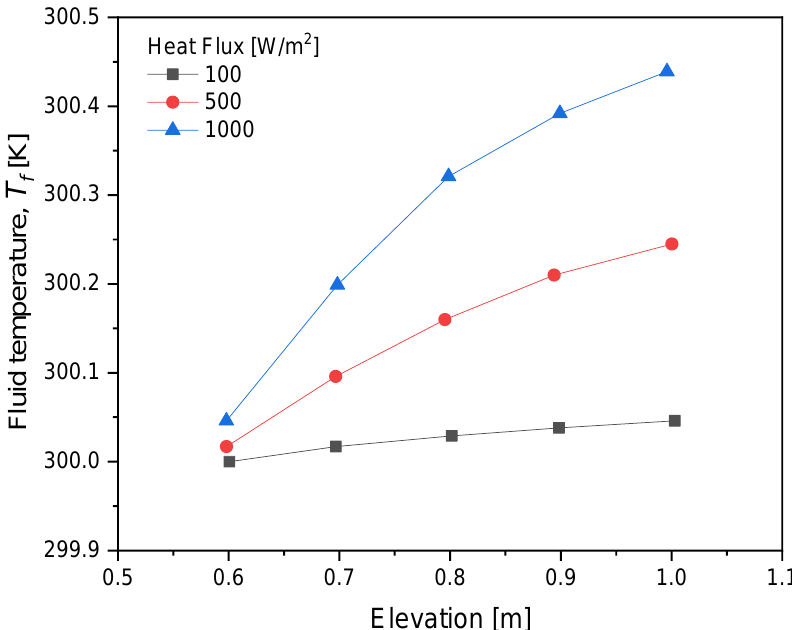
Figure 11. Influences of heat flux on fluid temperature for a water inlet velocity of 1 m/s.